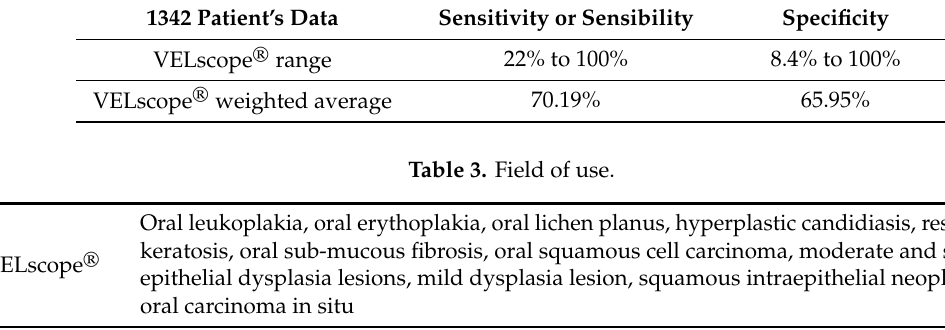
Table 2. Statistical data results.